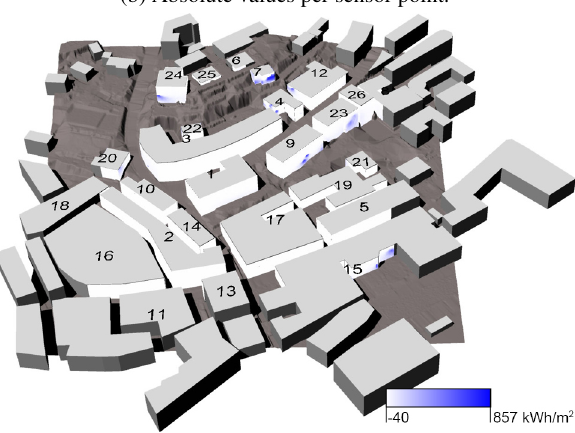
Figure 3. Difference of annual solar irradiation between scenario 0 and scenario 2 (tile